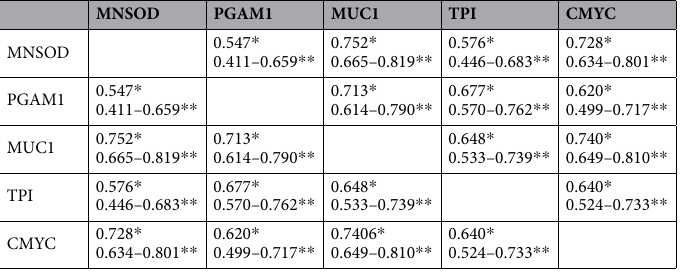
Table 2. Correlation among different autoantibody biomarkers. [ * Pearson correlation coeffient(r), ** 95% confidence interval for